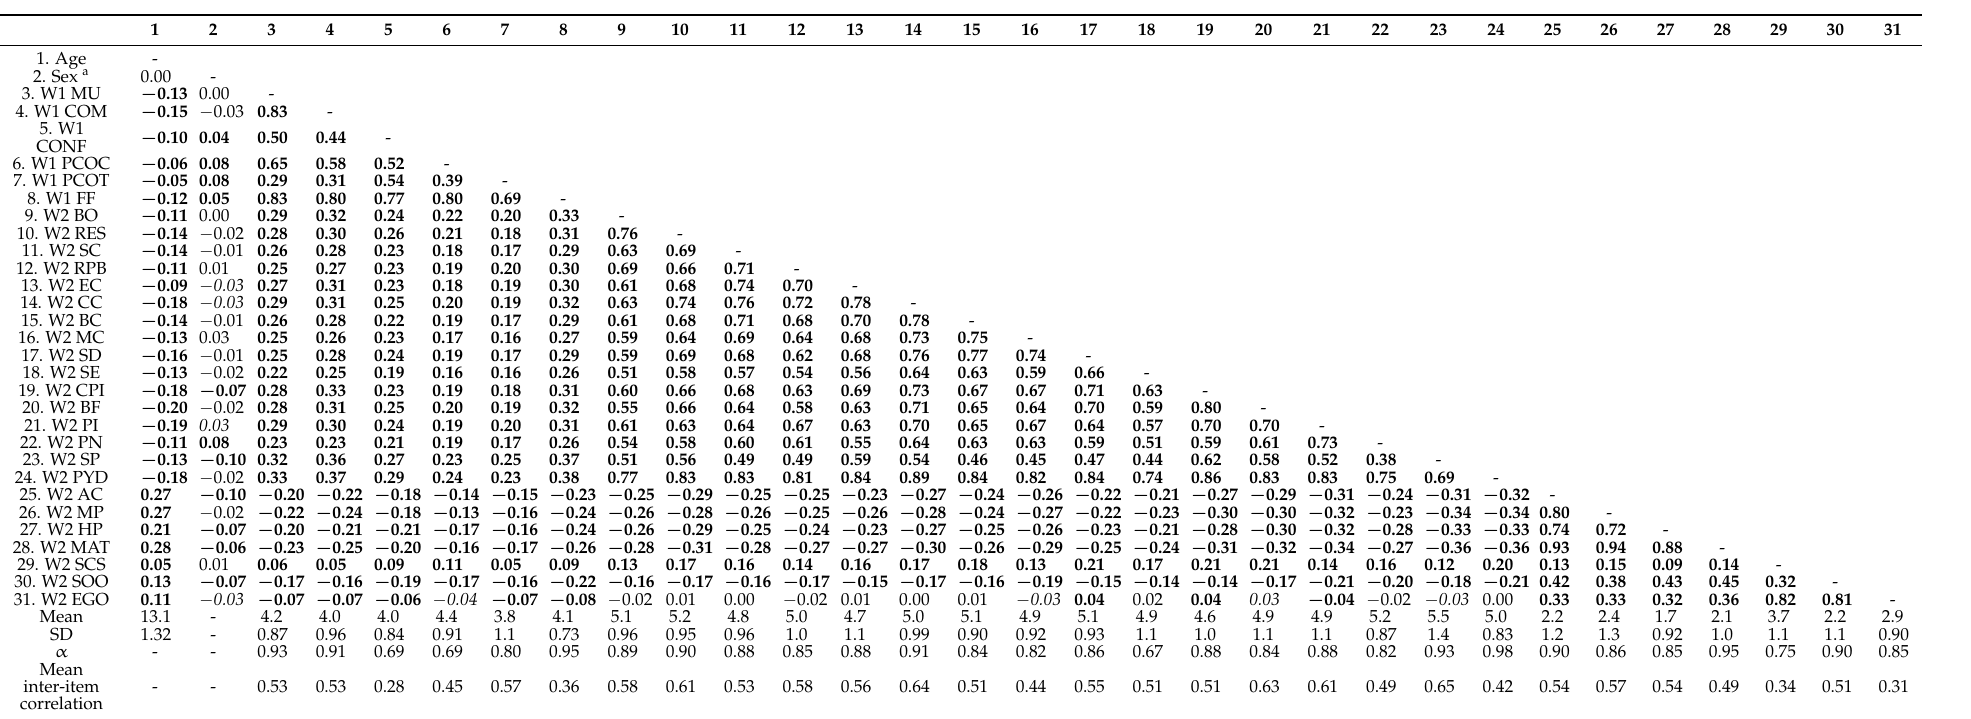
Table 1. Descriptive statistics, reliability, and inter-correlation of variables ( n =